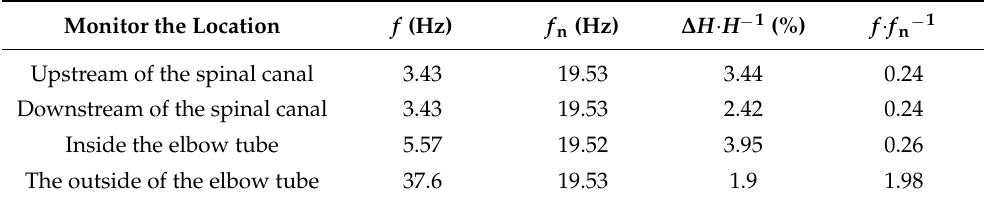
Table 4. Experimental value of pressure pulsation of draft tube (a 0 =33 mm).